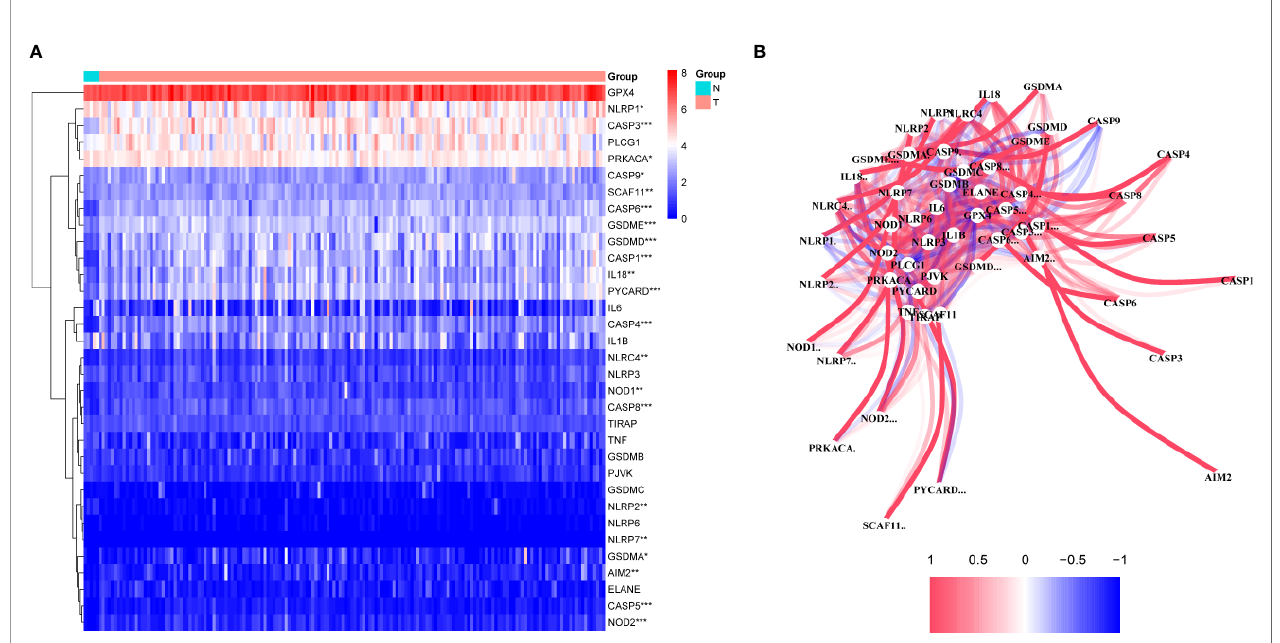
FIGURE 1 | Identi fi cation of the candidate genes. (A) Heatmap of the differential gene expression in the two groups. (B) The relationship between these